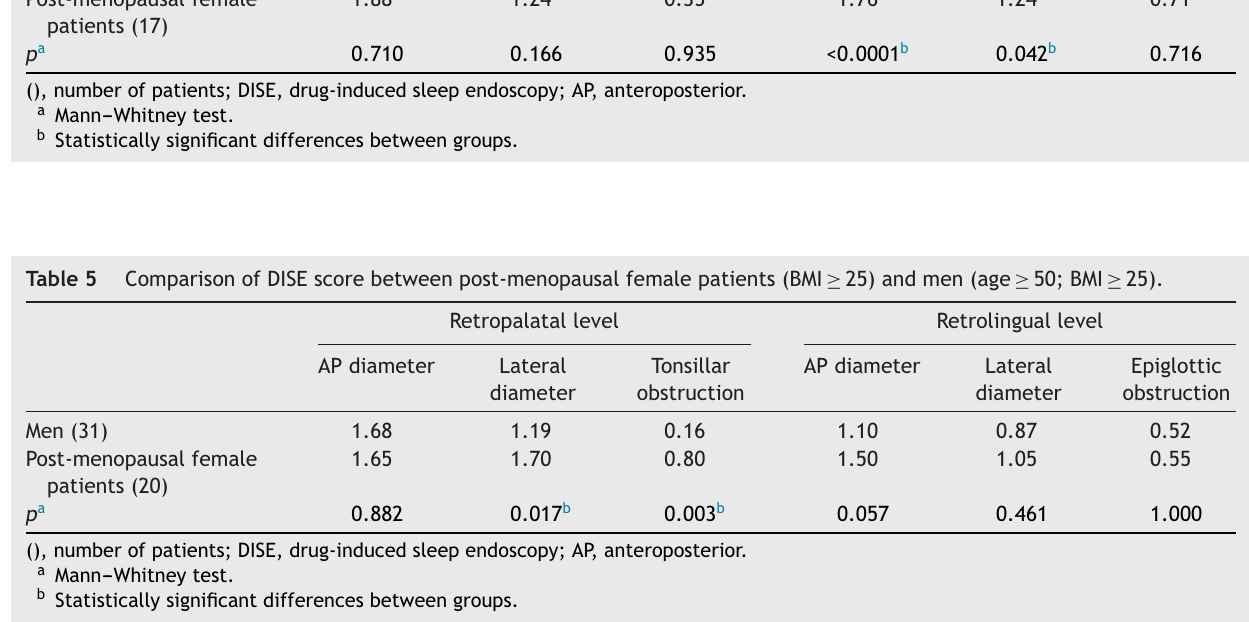
(), number of patients; DISE, drug-induced sleep endoscopy; AP, anteroposterior. a Mann---Whitney